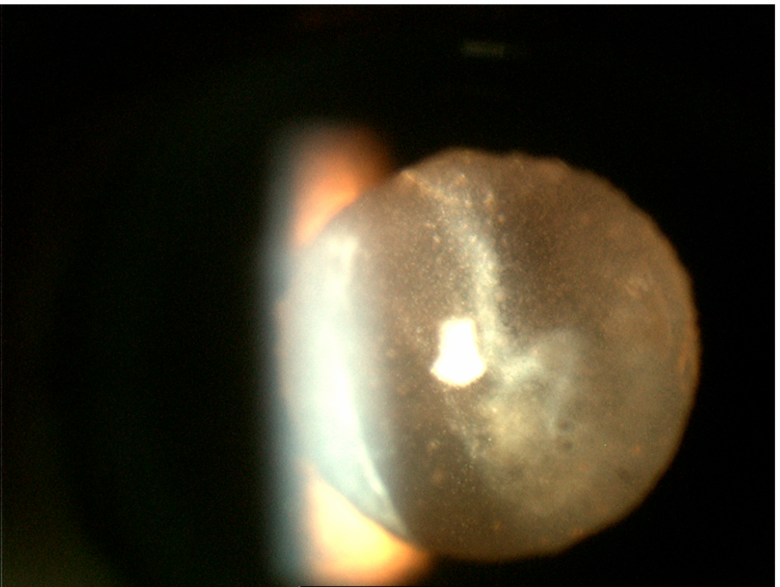
Figure 1. Slit lamp photograph of the retrolental region demonstrating sheets of numerous white cells of varied sizes infiltrating the vitreous. Most of these lymphoma cells tend to be larger than what is seen in vitritis.